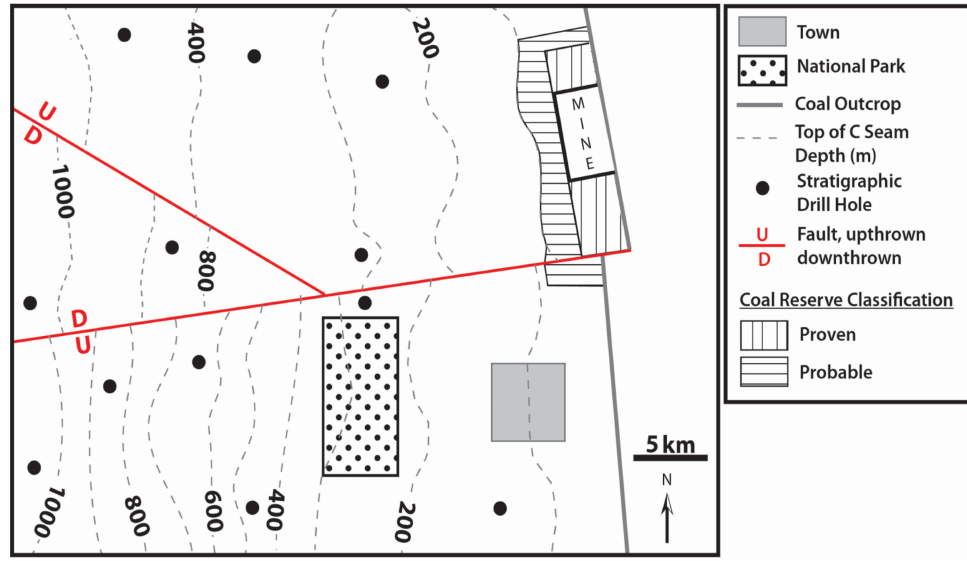
Figure 11. Hypothetical case study showing coal reserve